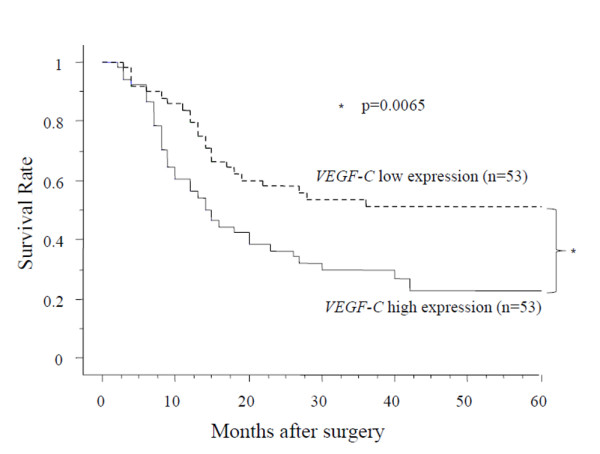
Survival rate of patients with ESCC according to the mRNA expression of VEGF-C. Patients with high expression of VEGF-C have significantly shorter survival after surgery (p = 0.0065 by log-rank test). The cut off value was median expression of VEGF-C